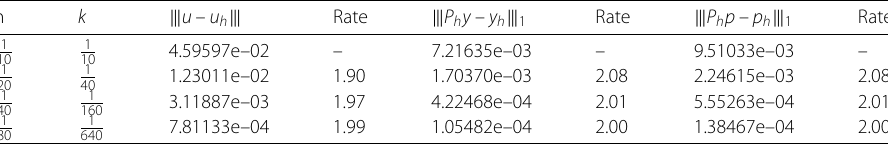
Table 1 Numerical results, Example 1